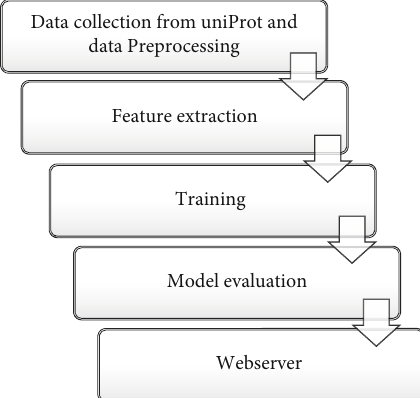
Figure 2: The work fl ow of the proposed model is shown which includes fi ve steps: data collection and its preprocessing, feature extraction, training, model evaluation, and the construction of the